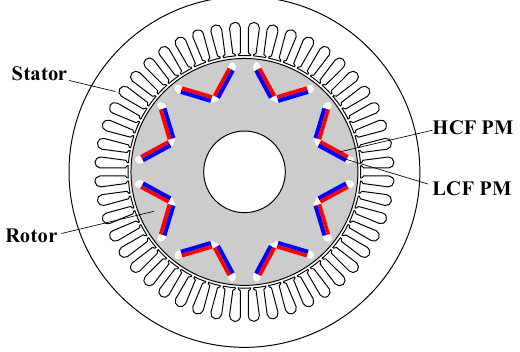
Figure 32. V ‐ type hybrid PM VFM machine with (Ce, Nd) ‐ Fe ‐ B material as LCF PM [84].